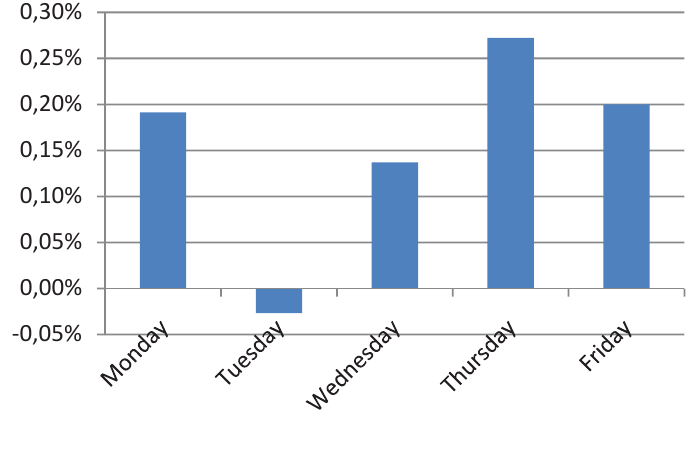
Fig. B1. Average analysis case of PFTS index